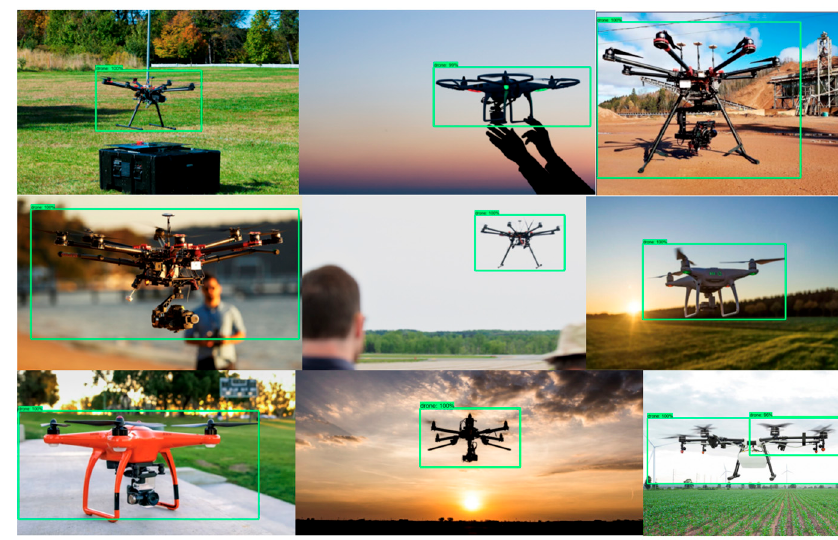
Figure 24. Testing the objects detection in the sky with an improved detector.